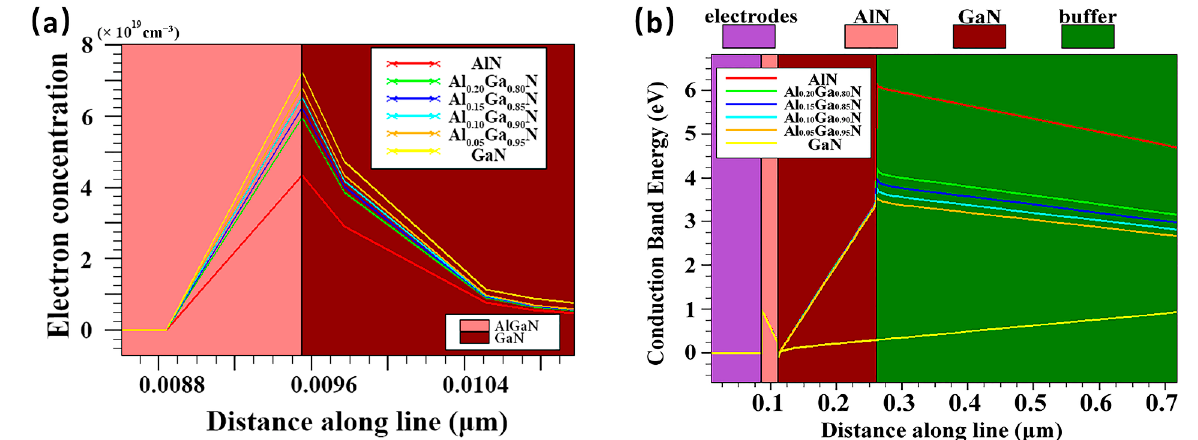
Figure 2. ( a ) Variation of electron concentration at AlGaN/GaN heterojunction interface with different buffer layers; ( b ) Conduction band distribution of HEMT devices with different buffer layers.